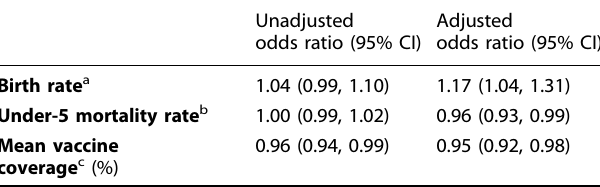
Table 4. Unadjusted and adjusted associations between birth rates, under-5 mortality rates, and mean vaccine coverage (predictors) and the occurrence of at least 1 year of negative indirect effects (outcome) from the logistic regression